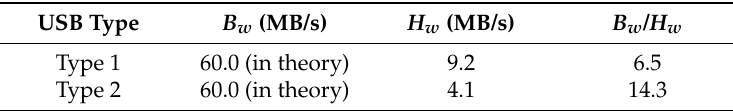
Table 3. The ratio of bandwidth to the writing